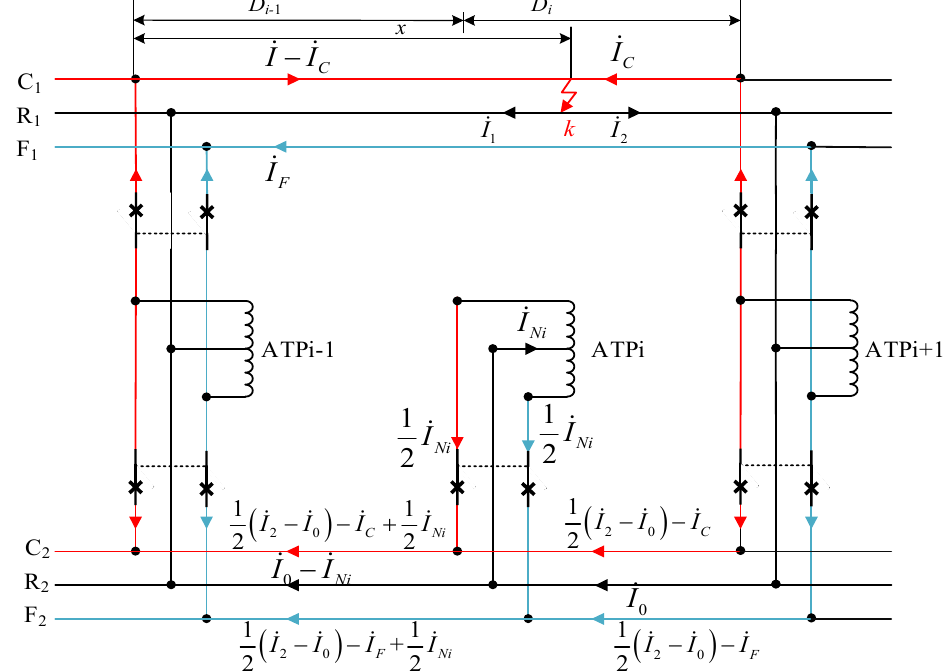
Figure 2. Current distribution in the up-down parallel (UDP) feeding condition.